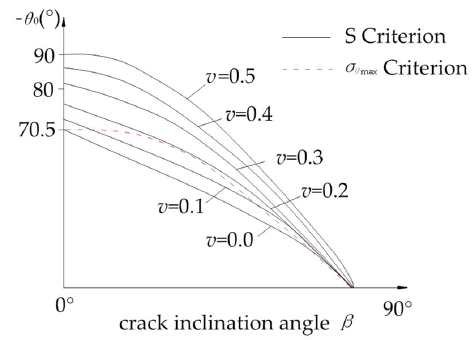
Figure 3. Relationship between the cracking angle and the crack inclination angle corresponding to different Poisson’s ratio.